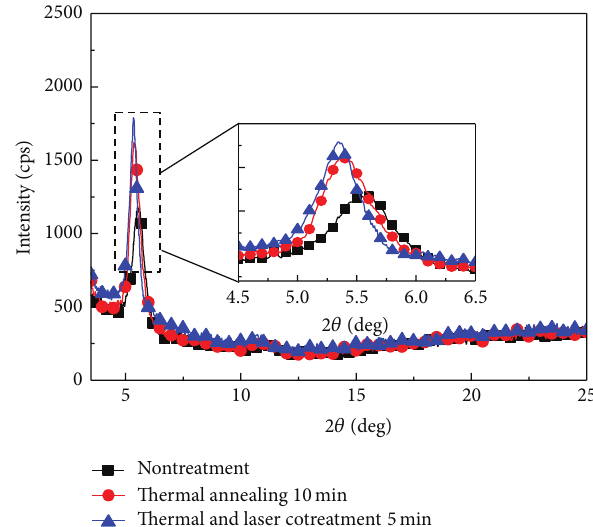
Figure 4: XRD spectra of P3HT:PCBM films under different annealing process. The insets show the zoomed-in graph of XRD spectra with the range from 2𝜃 = 4.5 ∘ to 2𝜃 = 6.5 ∘